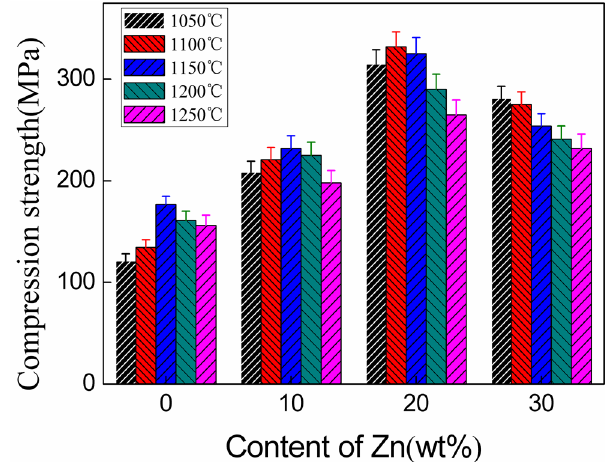
Figure 7. The compression strength of pure HA and ZnO / HA composites.